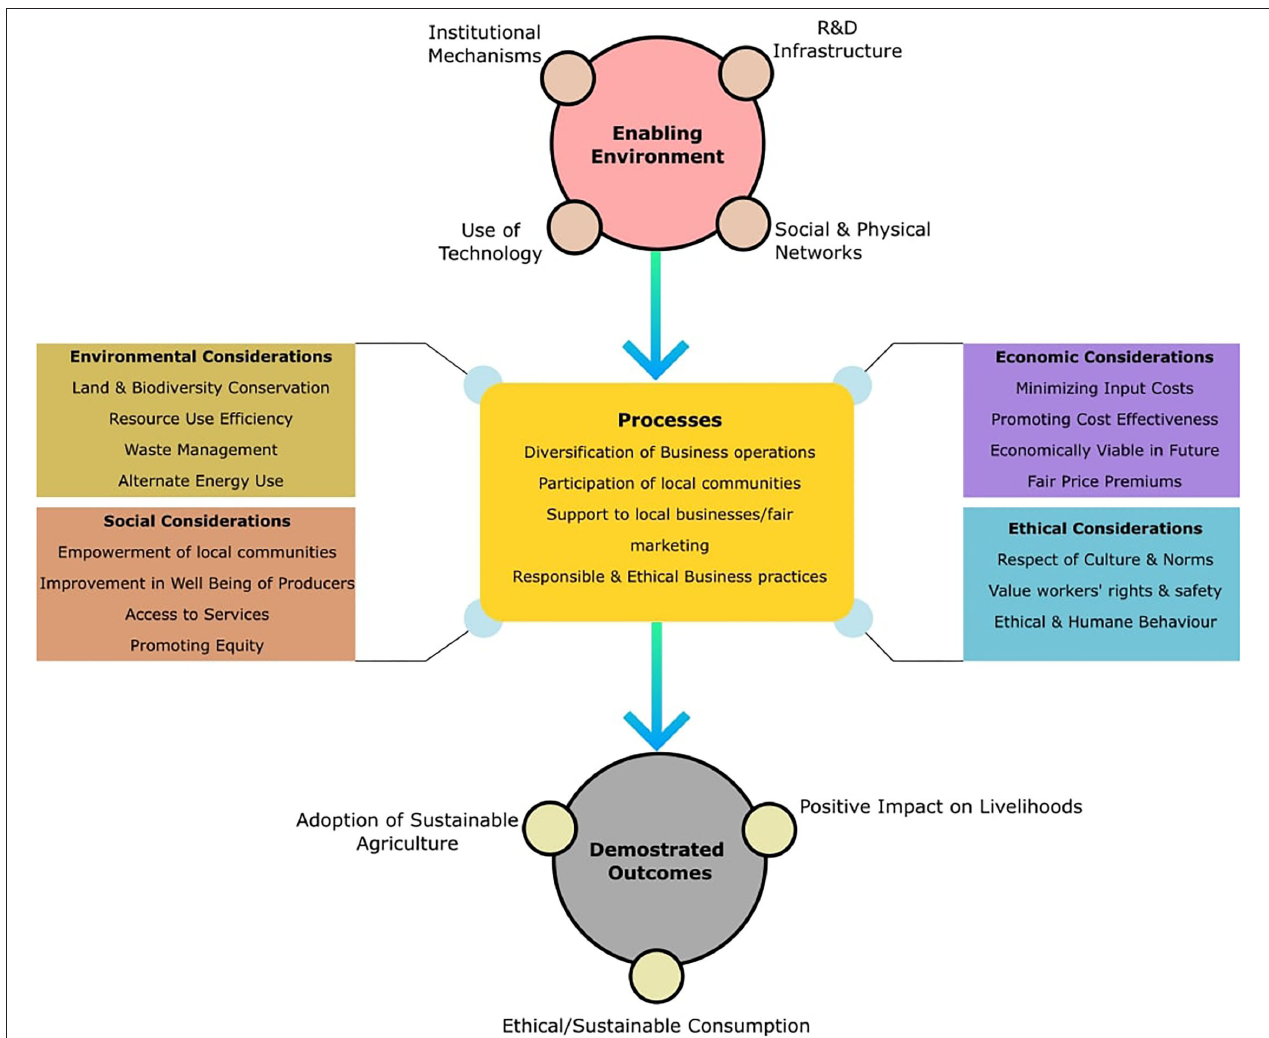
FIGURE 1 | Suggested framework for certification comparability on sustainability parameters. Centre for Sustainable Business, a 50% of CPG growth from 2013 to 2018 came from sustainability-marketed